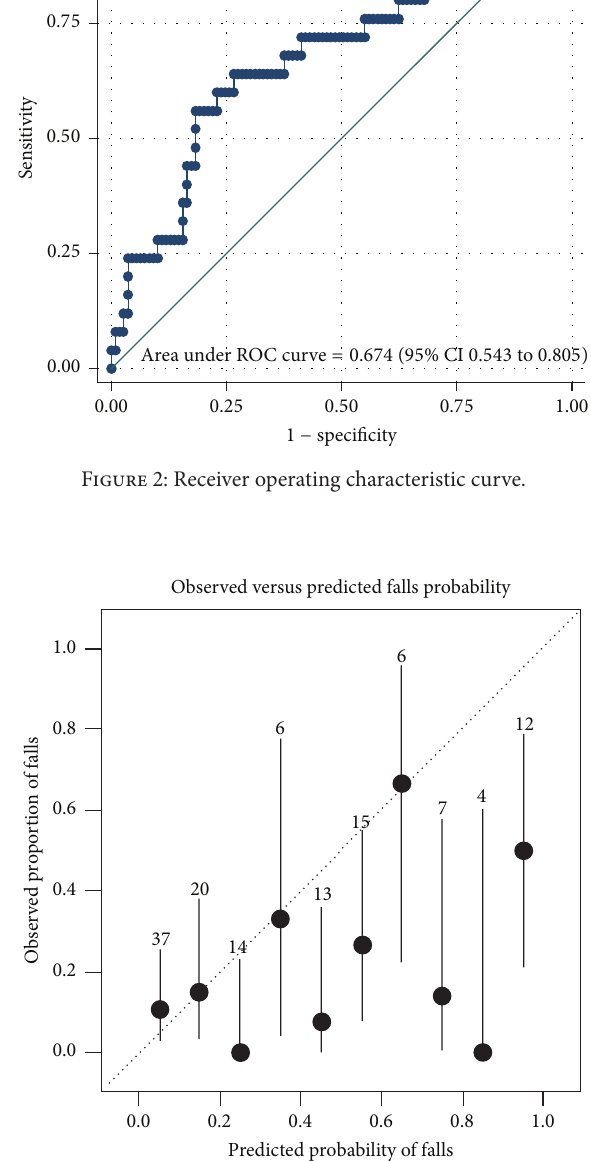
Figure 3: Probability for fall. Calibration plot of observed versus estimated probability for